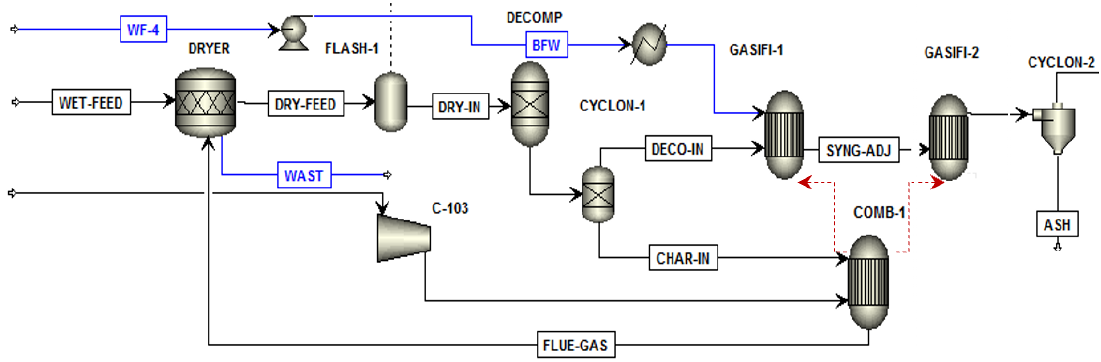
Figure 3. Process flow diagram for biomass gasification simulation using Aspen Plus.